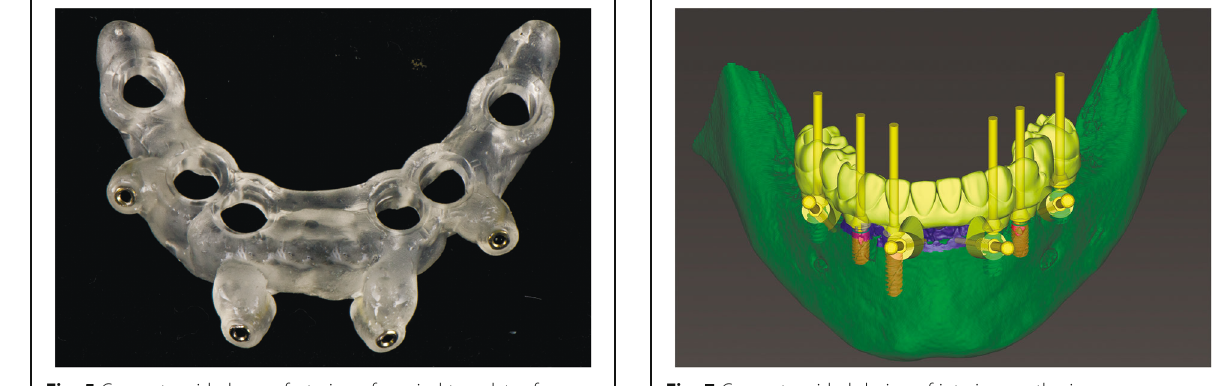
Fig. 5 Computer-aided manufacturing of surgical templates for fixating pins